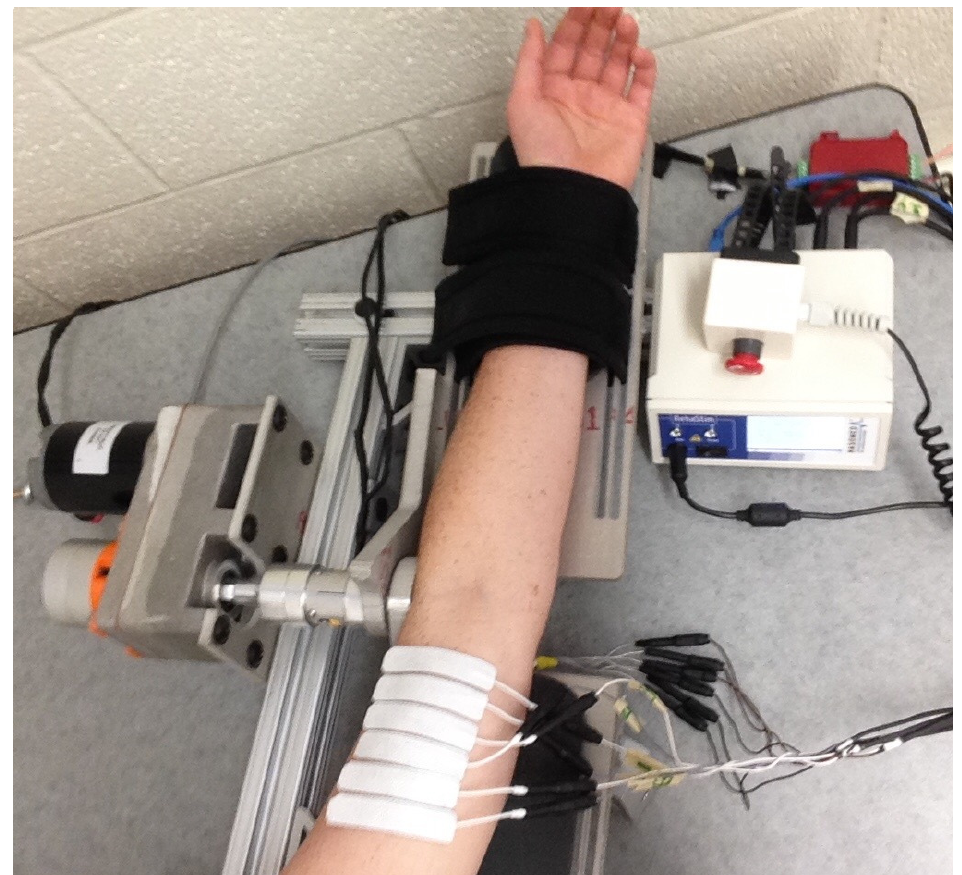
Figure 2. Six electrodes connected to a stimulator are evenly spaced on a particpants biceps brachii. The participant’s elbow joint is aligned with the motorized testbed’s joint axis. An emergency stop button is provided for participants to voluntarily stop the test at any